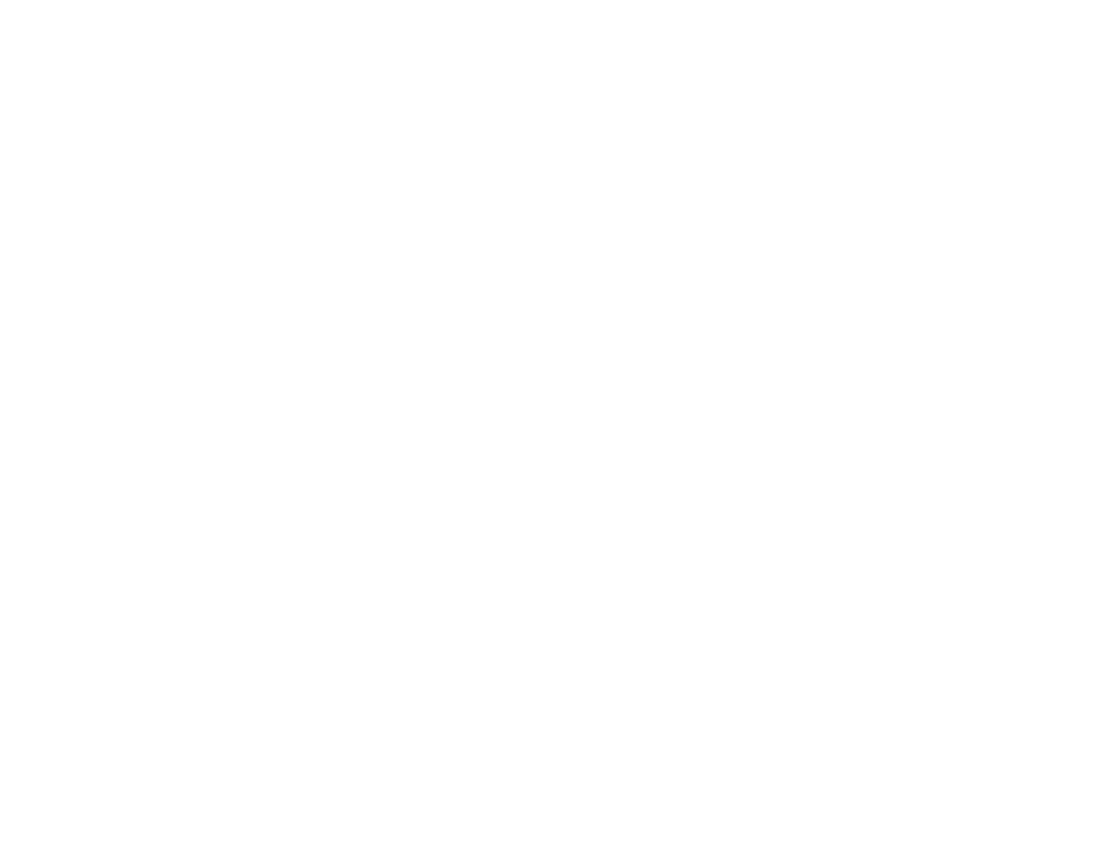
Figure 23. Example